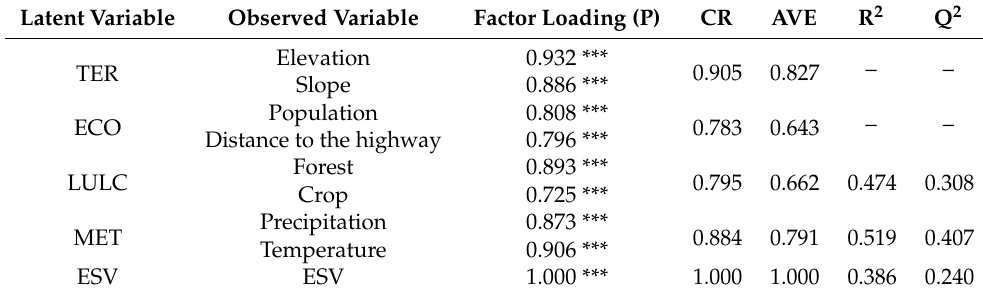
Table A2. Indicator parameter of